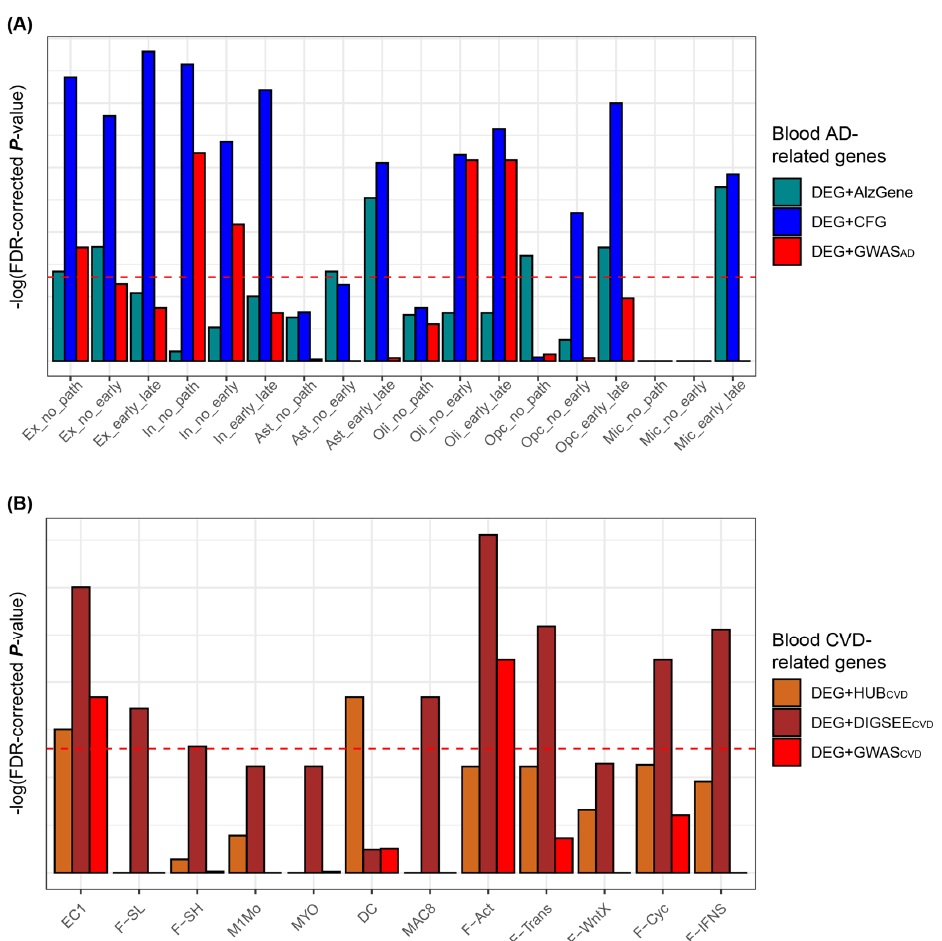
Figure 6. Comparison of the blood and the single-cell-based tissue DRGs. Red horizontal lines indi- cate an FDR-corrected p -value < 0.05, as measured by Fisher’s exact test. ( A ) “no_path”, “no_early”, and “early_late” indicate no pathology vs. AD pathology (early and late AD), no pathology AD vs. early AD, and early vs. late AD, respectively. ( B ) Twelve groups after excluding 23 insignificant cases out of 35 clusters of cell type-specific DEGs obtained from CVD mouse hearts are used for the comparisons. Horizontal lines in A and B indicate an FDR-adjusted p -values < 0.05, as measured using Fisher’s exact test. AD, Alzheimer’s disease; CVD, cardiovascular disease; AUC, area under the receiver operating characteristic curve; DEG, differentially expressed gene; TF, transcription factor; CFG, convergent functional genomics; eQLT, expression quantitative trait loci; GWAS, genome-wide association study; Ex, excitatory neurons; In, inhibitory neuron; Ast, astrocyte; Oli, oligodendrocyte; Opc, oligodendrocyte progenitor cell; Mic, microglia; EC, Endothelial cel; F-SL, fibroblast- Sca1 -low; F-SH, fibroblast- Sca1 -high; M1Mo, M1 monocyte; MYO, Myofibroblast; DC, dendritic cell; MAC, macrophage; F-Act, fibroblast-activated; F-trans, fibroblast-transitory; F-WntX, fibroblast-Wnt expressing; F-Cyc, fibroblast-cycling; F-IFNS, fibroblast-IFN stimulated. For the heart CVD single-cell analyses, the gene expression dataset by Farbehi et al. [47] was analyzed. Single-cell analyses were performed twice (TIP and GFP), from which we curated 24 and 11 lists for the single-cell-based DEGs between the two